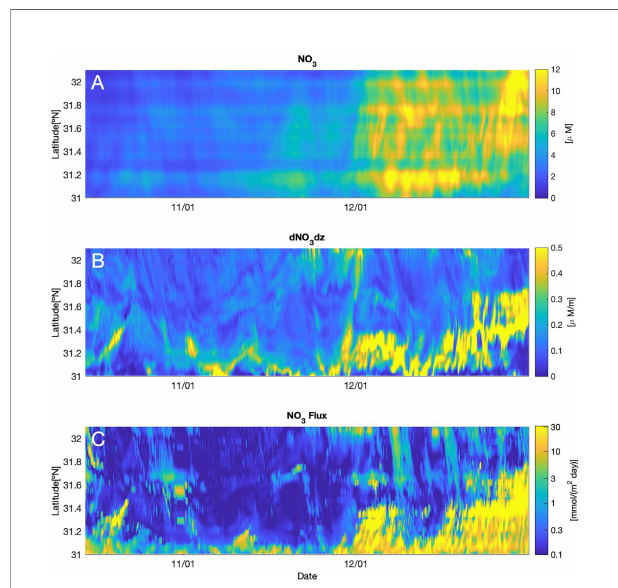
FIGURE 10 | Hovmoeller plot of (A) nitrate concentration ( m M), (B) nitrate vertical gradient ( m Mm -1 ) and (C) nitrate diffusive fl ux (mmol m -2 day -1 ) interpolated at 100 m depth and averaged zonally over the continental shelf, where depth is less than 200 m depth, as a function of latitude and